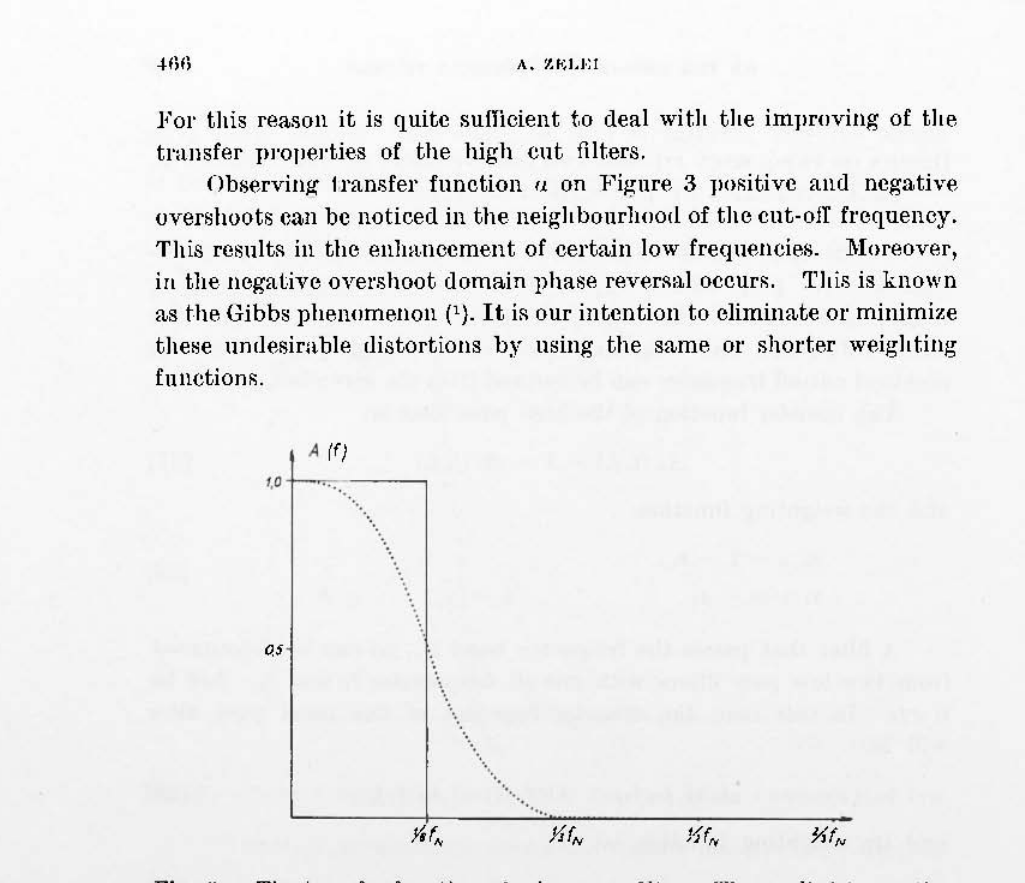
Fig. 5 - The tranilfer f!Ulction of a low paHS filte!". '['he al1ll!iell tmncating functiuns is fdi: